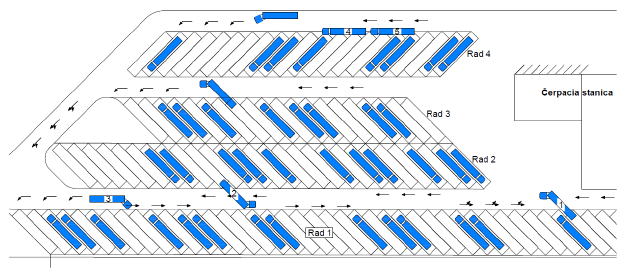
Figure 1. Return allowing car park.